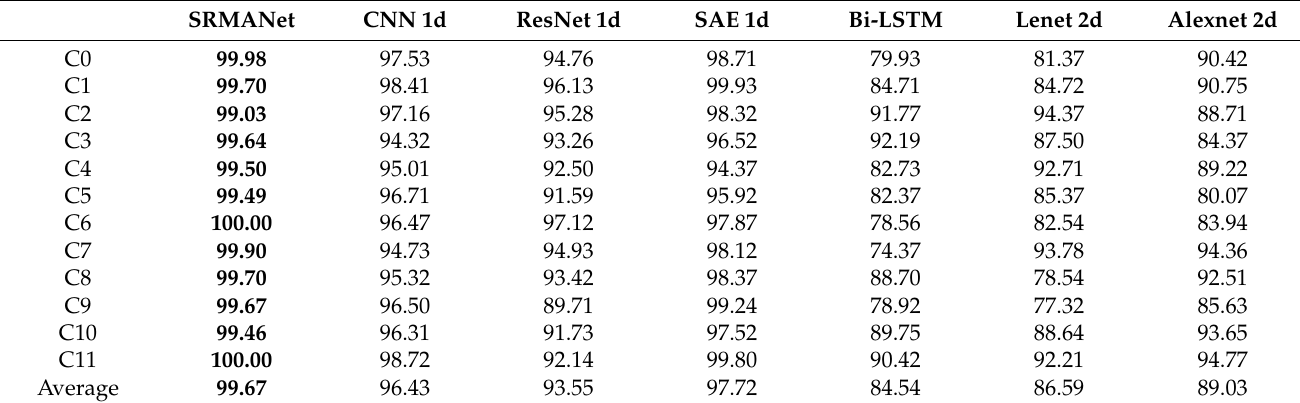
Table 4. Fold-1 accuracy (%) of different DNN models.